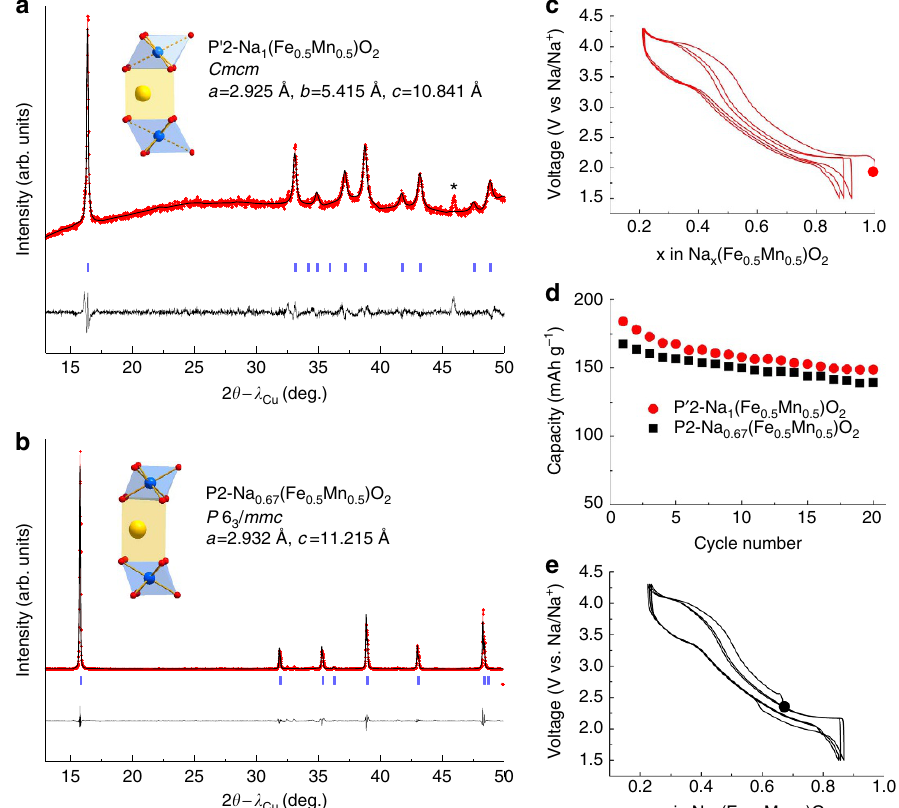
Figure 2 | Synthesis of the P 0 2 phase by Na ball milling. XRD powder pattern profile matching and schematic representation of the structure